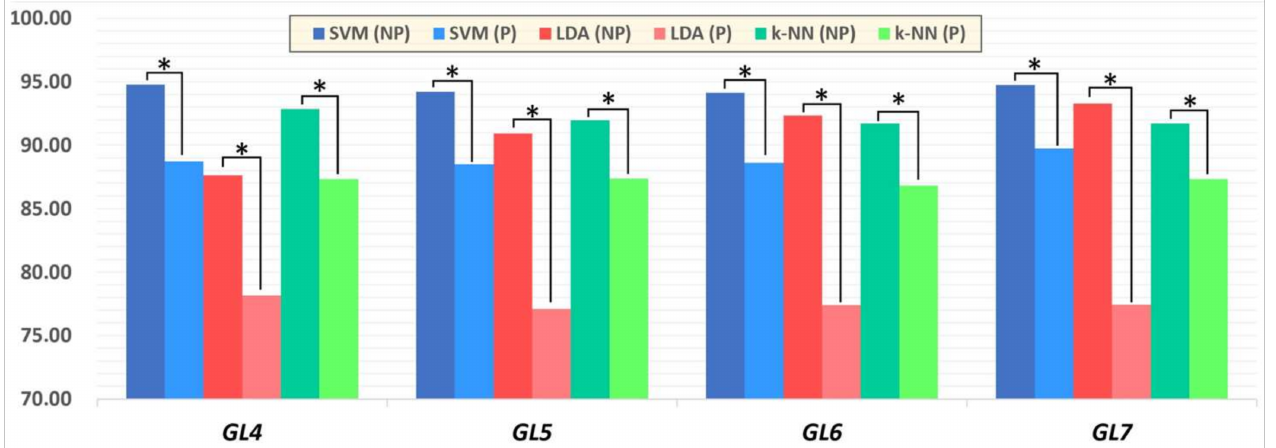
Figure 5. Total mean accuracy rate among GLs using SVM, LDA, and k-NN. Asterisks indicates statistical significance between paretic and non-paretic pairs using a paired t -test (* p <